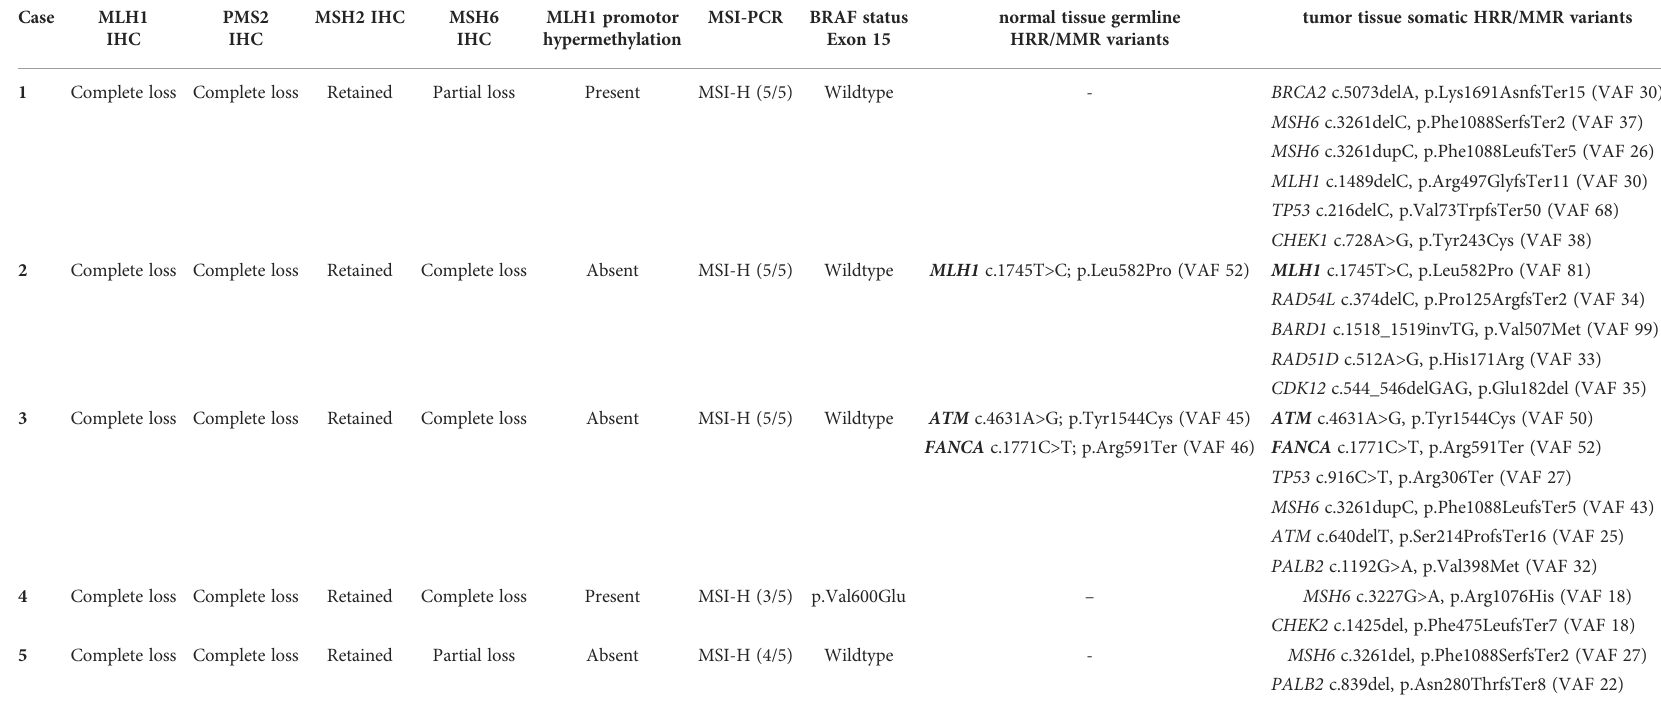
TABLE 2 MMR immunoexpression and molecular characterization of MLH1 - /PMS2 - /MSH6 - digestive system cancer